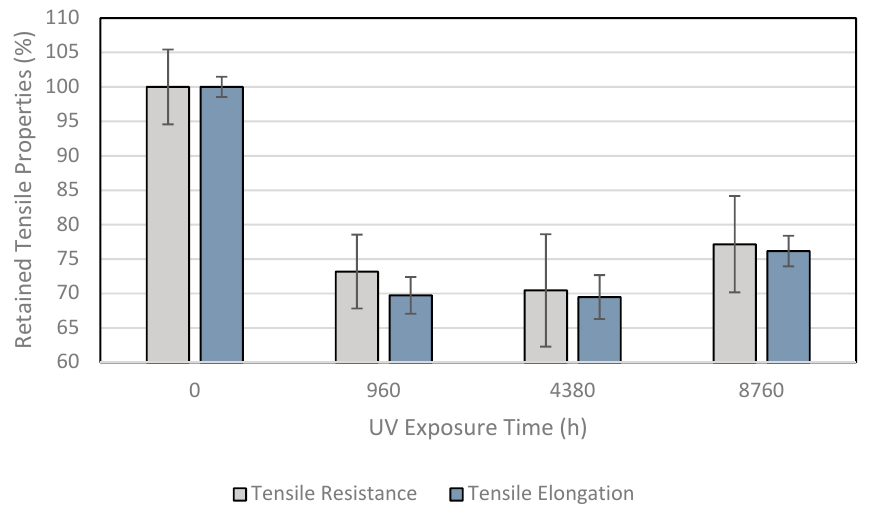
Figure 2. Tensile behavior of the samples after UV fluorescent device exposure.